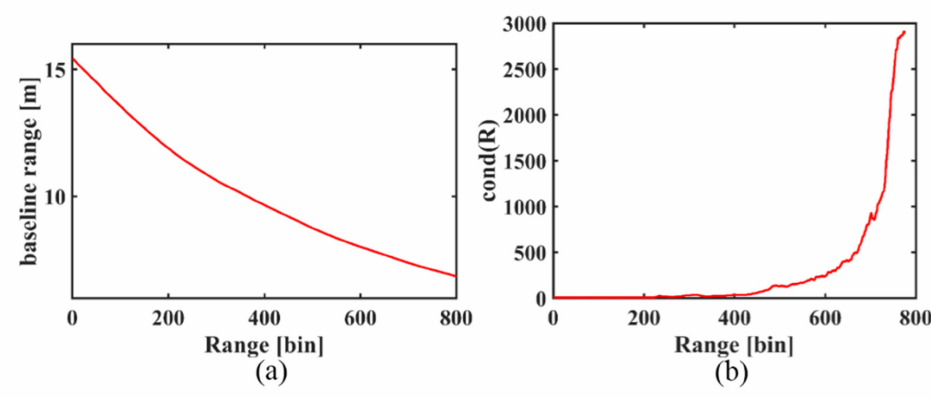
Figure 12. ( a ) The tomographic aperture at different range locations. ( b ) The condition number of the covariance matrix at different range